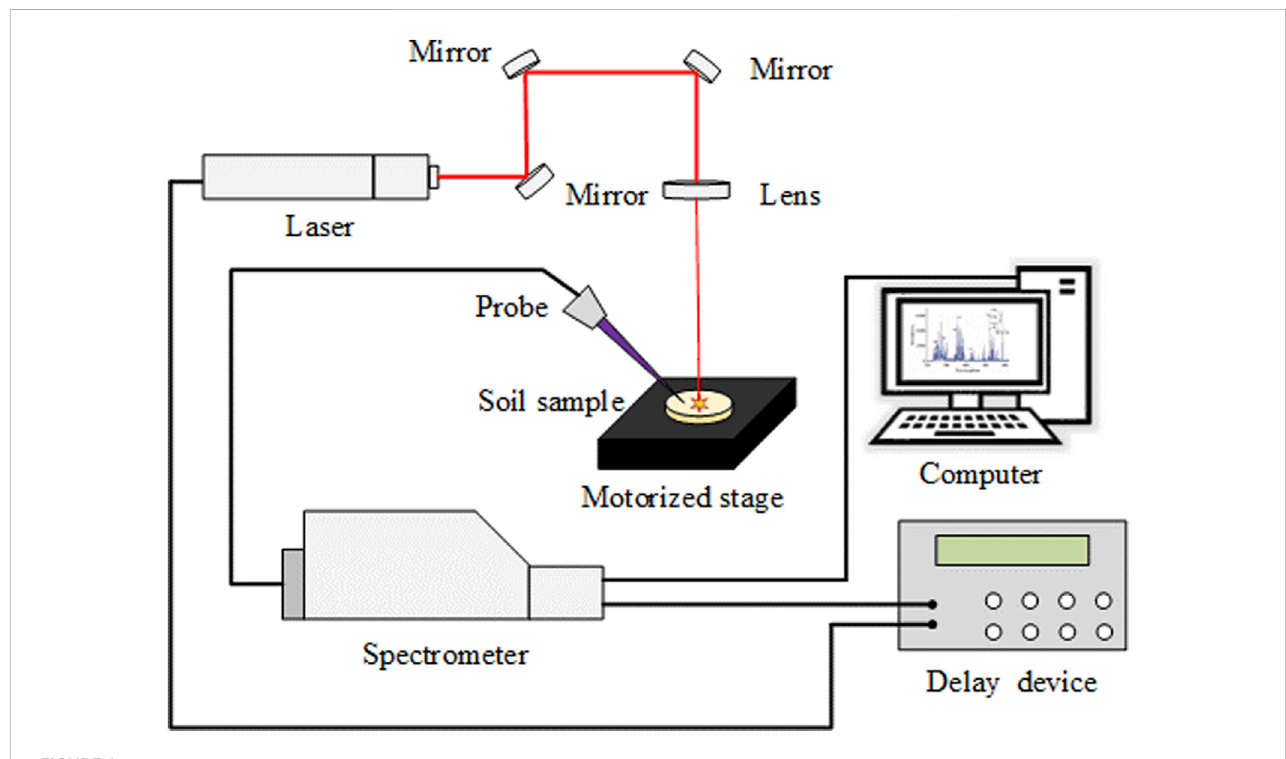
FIGURE 1 Experimental